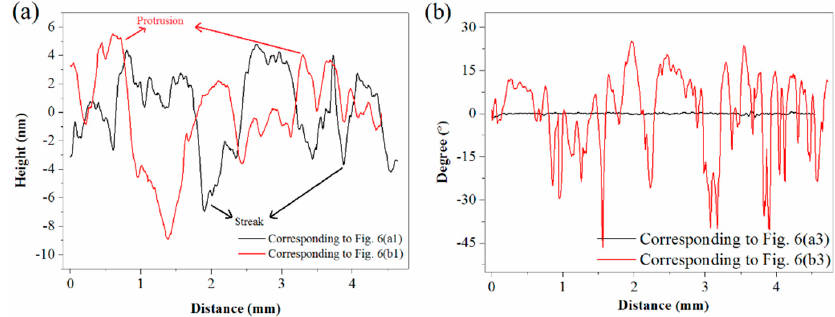
Figure 8. ( a ) Height profiles. ( b ) Phase shifts.